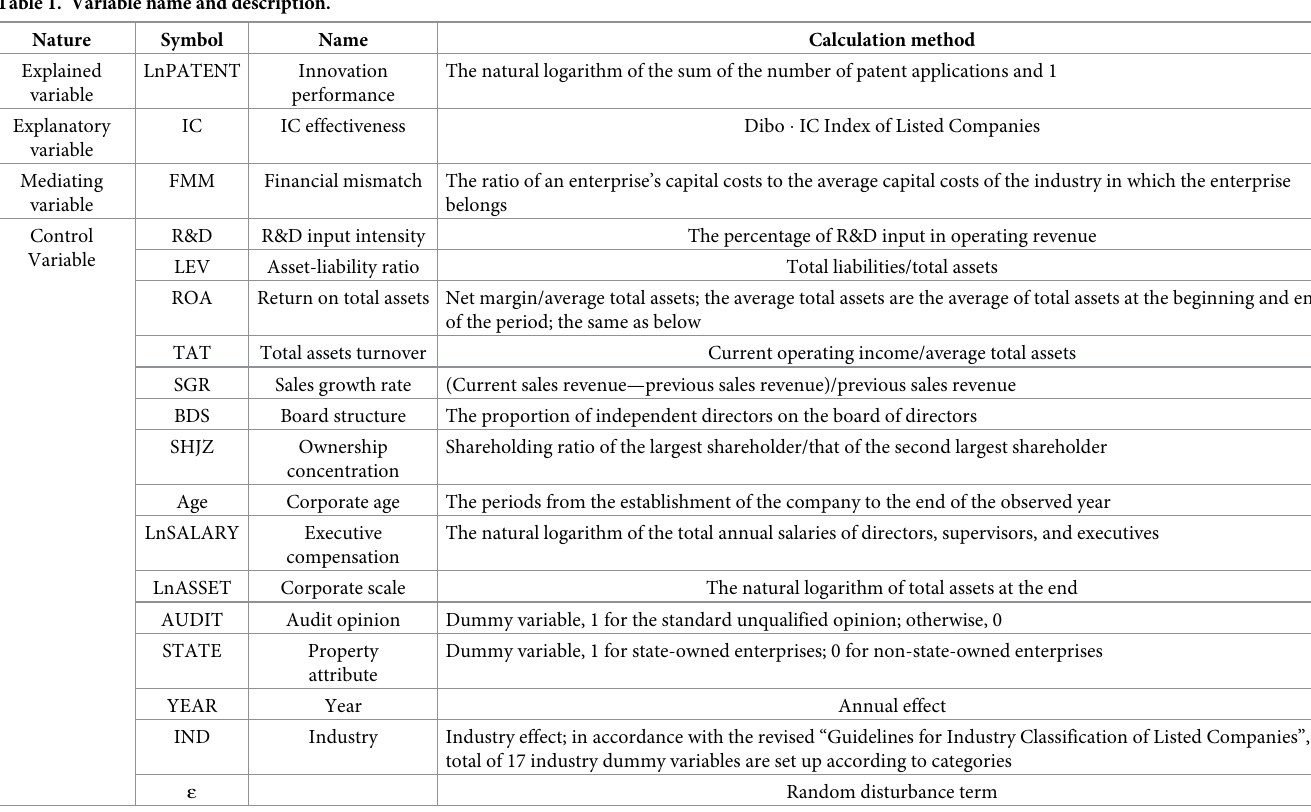
Table 1. Variable name and